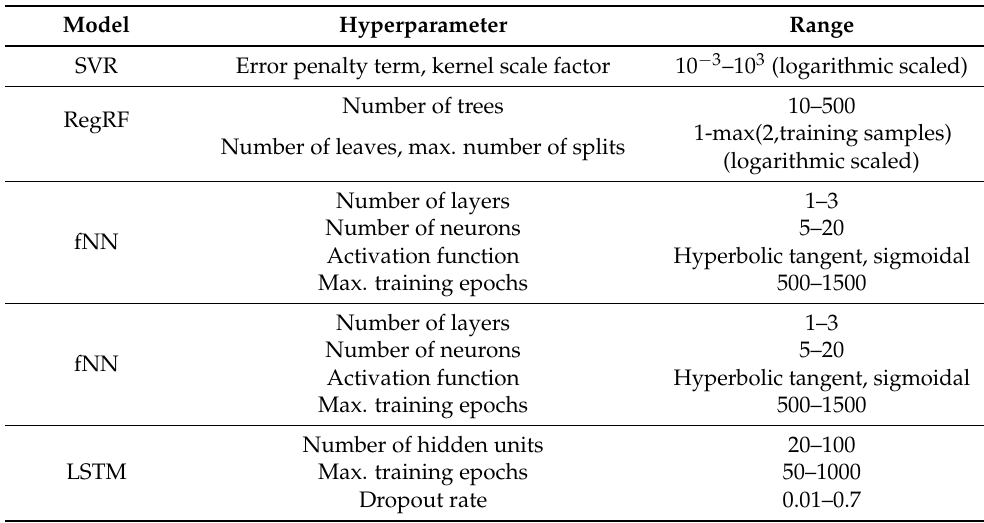
Table 1. Nonlinear model